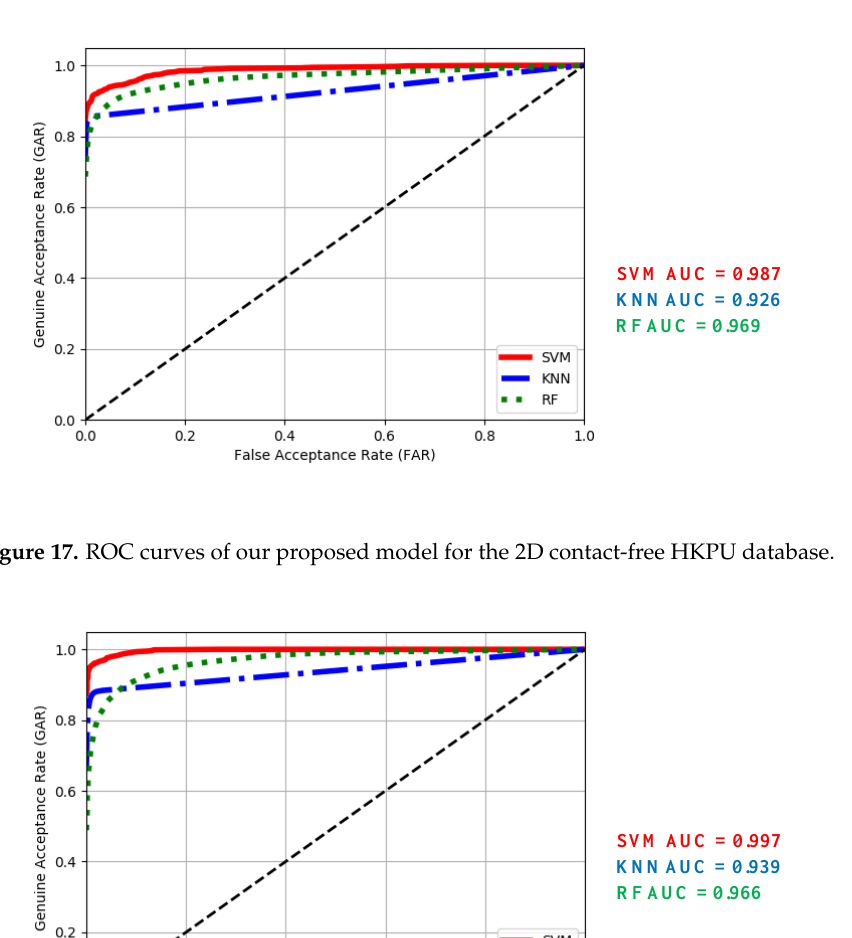
Figure 16. Receiver operating characteristic (ROC) curves of our proposed model for the contact-based HKPU database. AUC: area under the ROC curve.